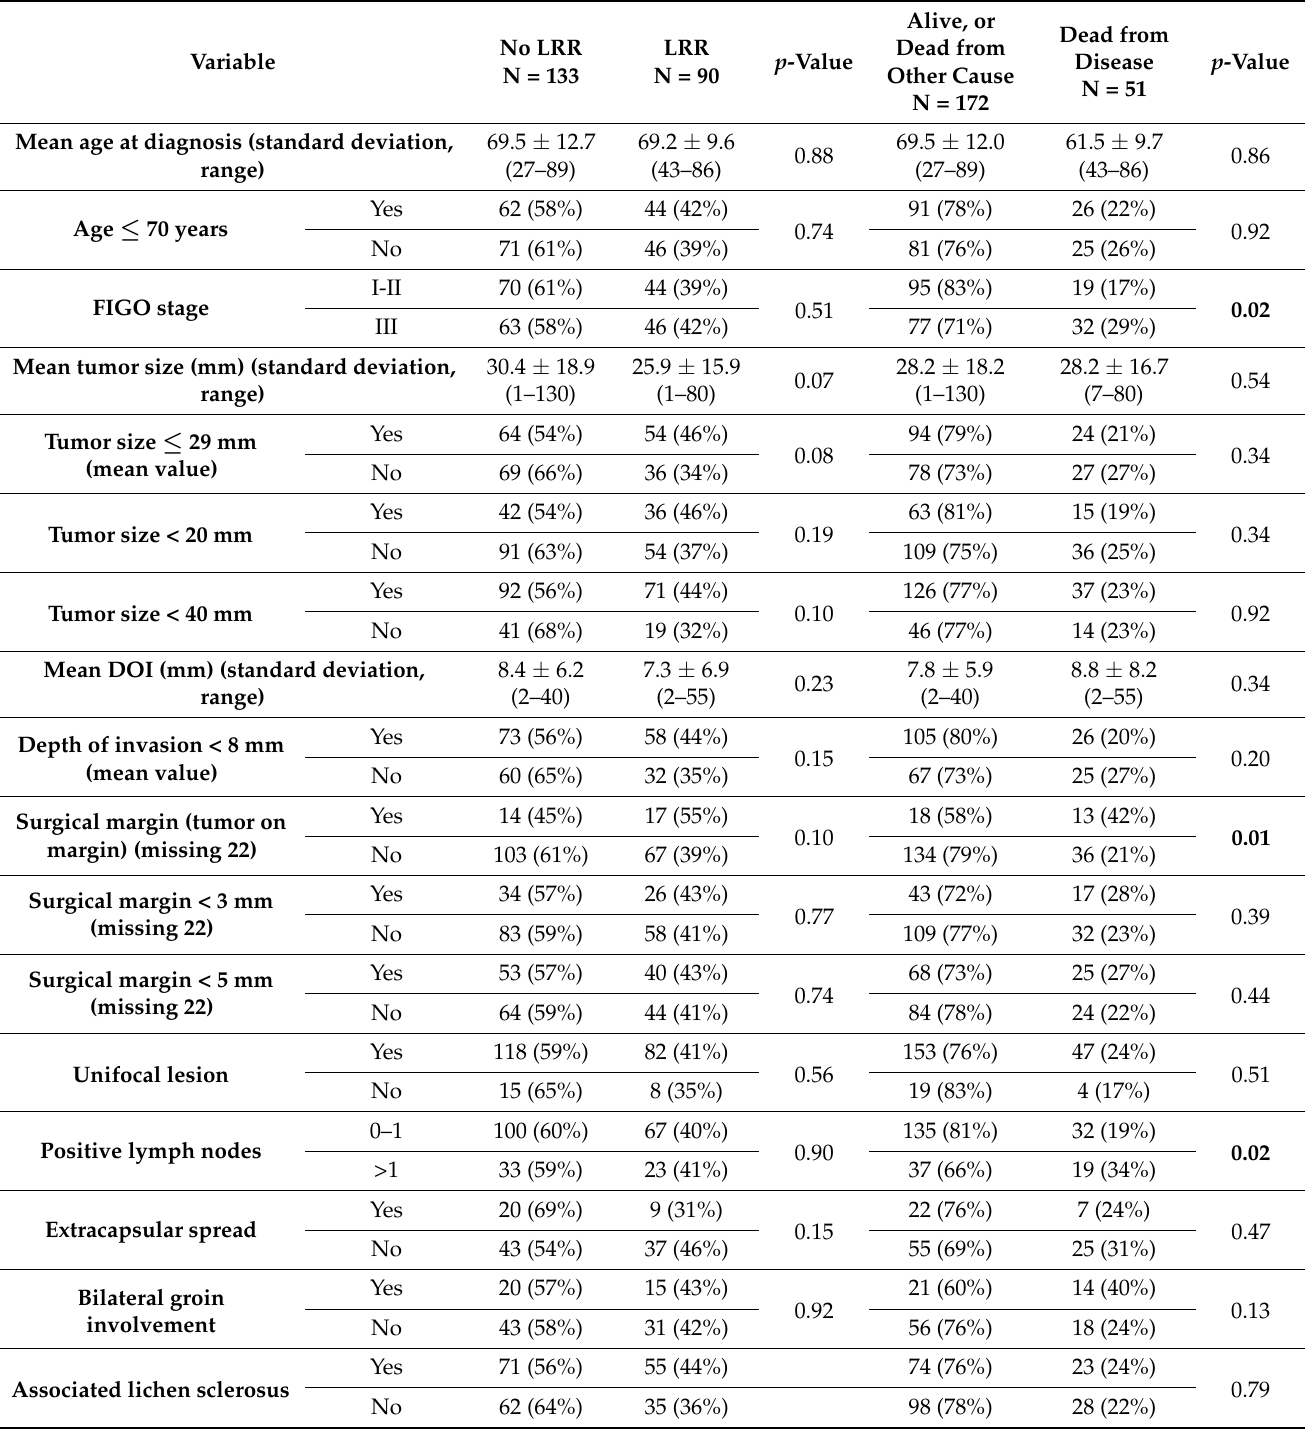
Table 2. Demographic, clinical, surgical, and histopathological characteristics according to locore- gional recurrence (LRR) and cancer-specific survival ( n = 223). (Statistically significant factors are highlighted in